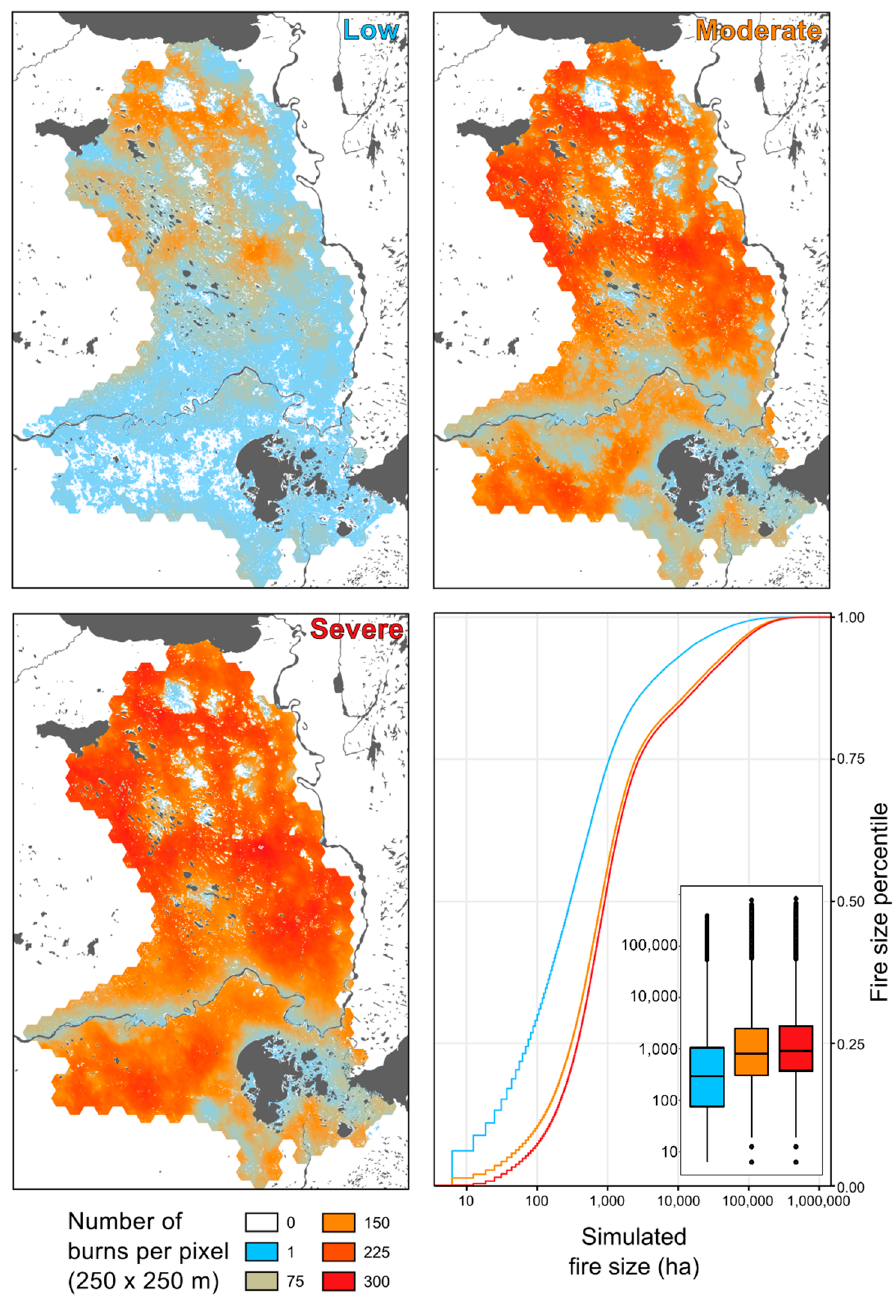
Figure 3. Burn rate (number of burns per 100,000 ignitions) across the study domain as a function of drought scenario: low 250), moderate (DC 500), or severe (DC 750). Cumulative fire size distributions for the respective scenarios are also shown on a log 10 scale with inset boxplots of the same data.